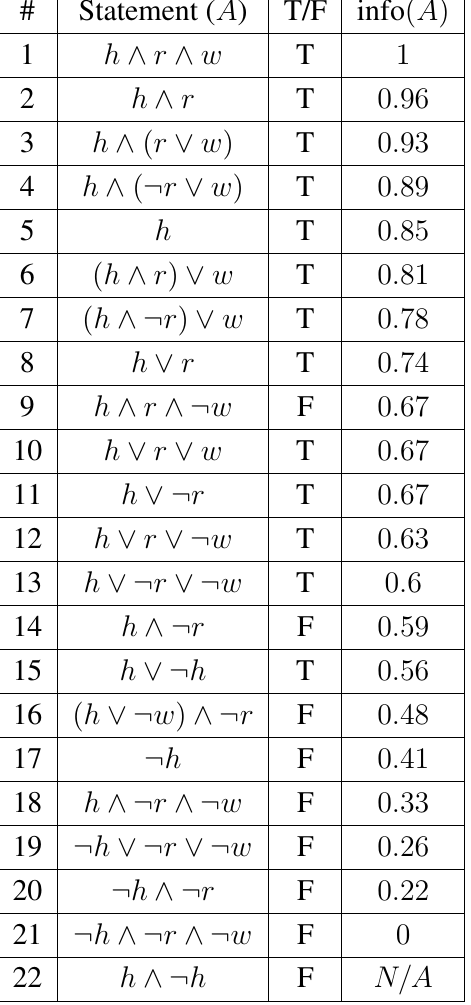
Table 9. Information yield results using Niiniluto’s min-sum